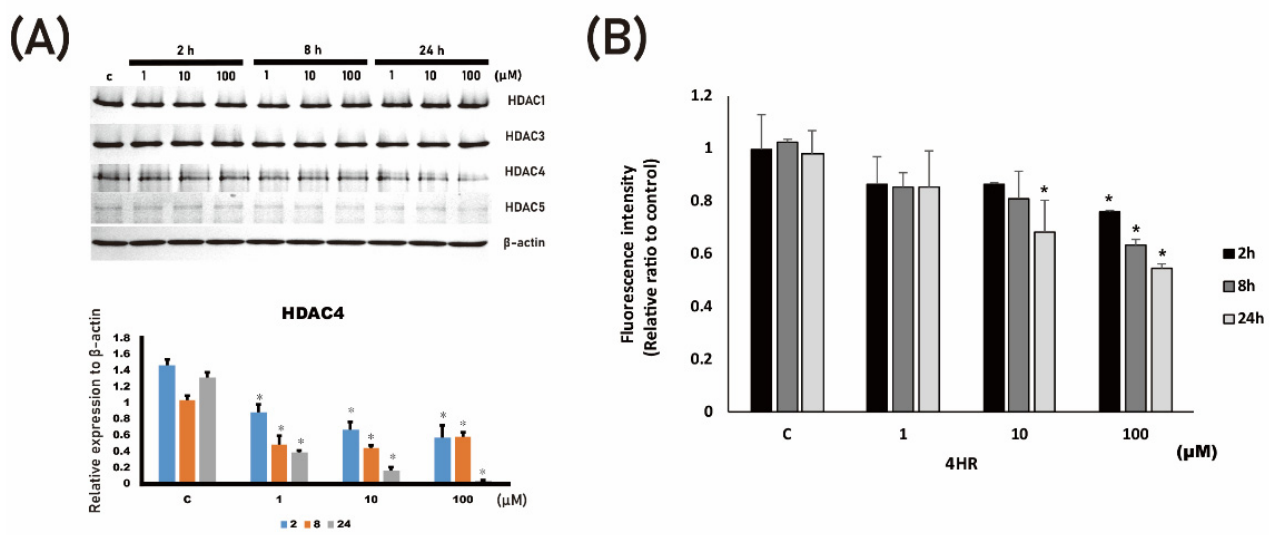
Figure 3. The change in p53 acetylation levels and HDAC activity. ( A ) The expression levels of HDAC4 decreased after 4HR treatment ( A ). The differences were statistically significant ( p < 0.05). ( B ) When compared to the untreated control, HDAC activity was significantly inhibited upon 4HR treatment (* p < 0.05 by Bonferroni test).